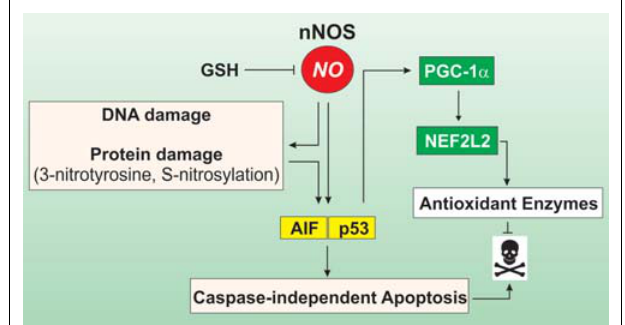
FIGURE 1 | Role of GSH in modulating cell response to NO. In cells of neuronal or muscle origin NO is produced by neuronal nitric oxide synthase (nNOS). Intracellular GSH is a crucial factor in modulating NO reactivity, as it functions as an efficient NO buffer.When GSH levels decline, NO availability is increased and may trigger DNA damage as well as protein oxidation, in terms of S -nitrosylation of cyteines and formation of 3-nitrotyrosine on protein residues.This leads to induction of caspase-independent apotosis via the activation of the apoptosis inducing factor (AIF). Concomitantly, p53 is activated and binds to consensus sequence of PGC-1a promoter increasing its expression. PGC-1a in turn co-activates the NEFL2-dependent expression of antioxidant genes, thus limiting oxidative damage and cell